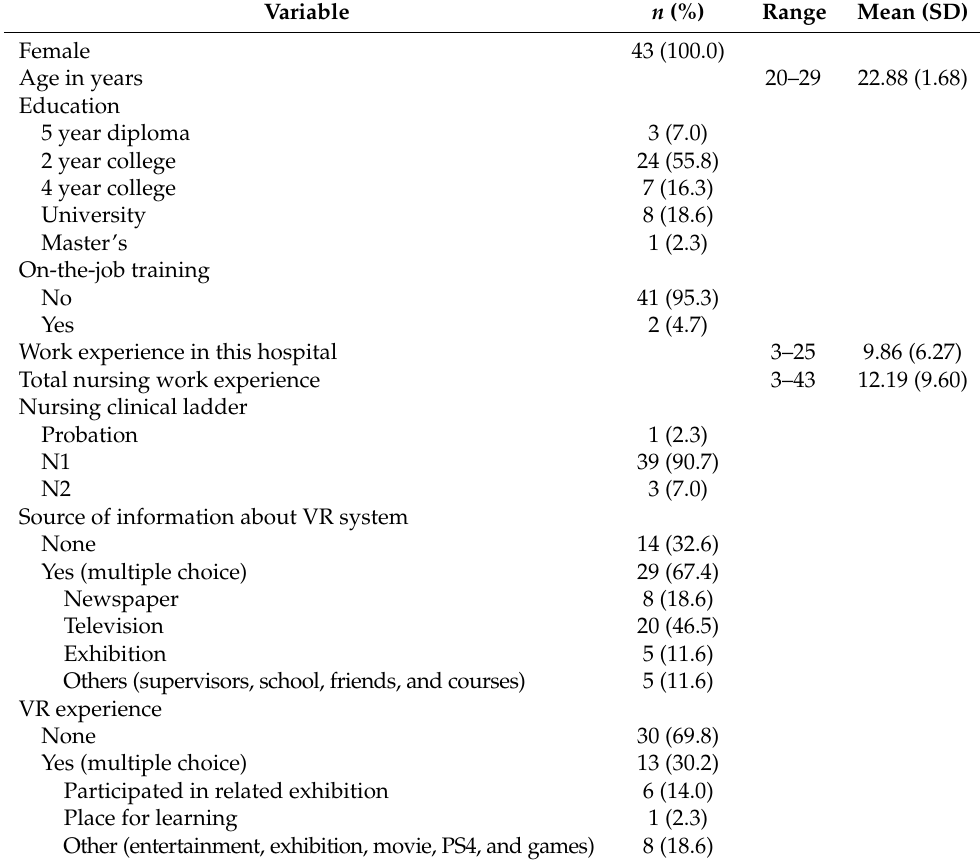
Table 5. Distribution of background information on nurses ( n =